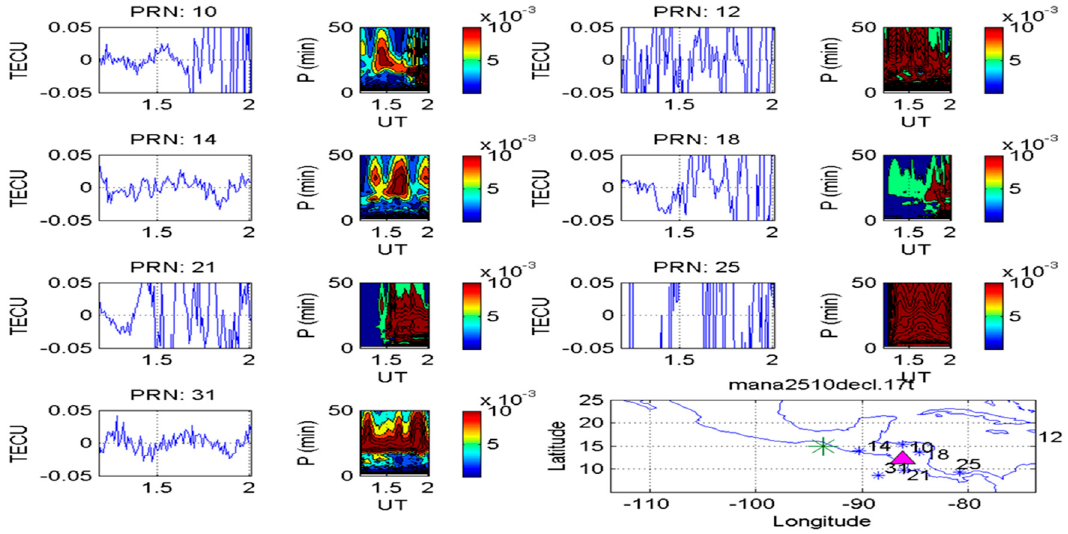
Figure 9. Fluctuations of differential slant TEC obtained from the MANA station and PRN satellites passing over the earthquake preparation area on 8 September 2017 (DoY 251) at 1.5–2.0 UT. Power spectrograms of normalized amplitude are also shown. Map shows earthquake epicenter (green asterisk), MANA station (pink triangle), number and position of satellite (blue asterisks).